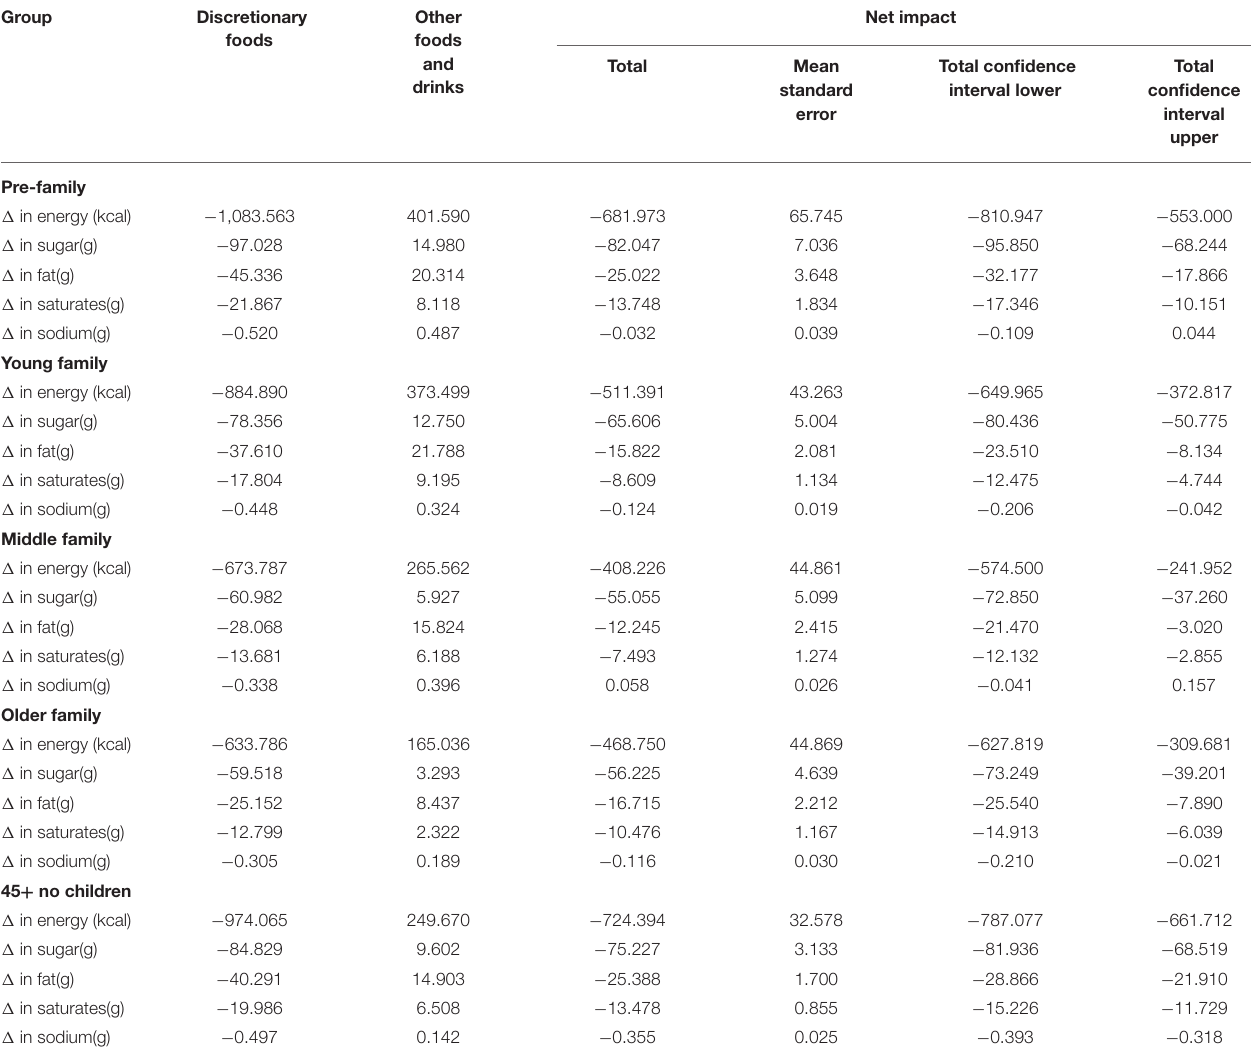
TABLE 5 | Net results of the simulation on discretionary foods-by lifestage classification (Changes are in per capita per week terms).